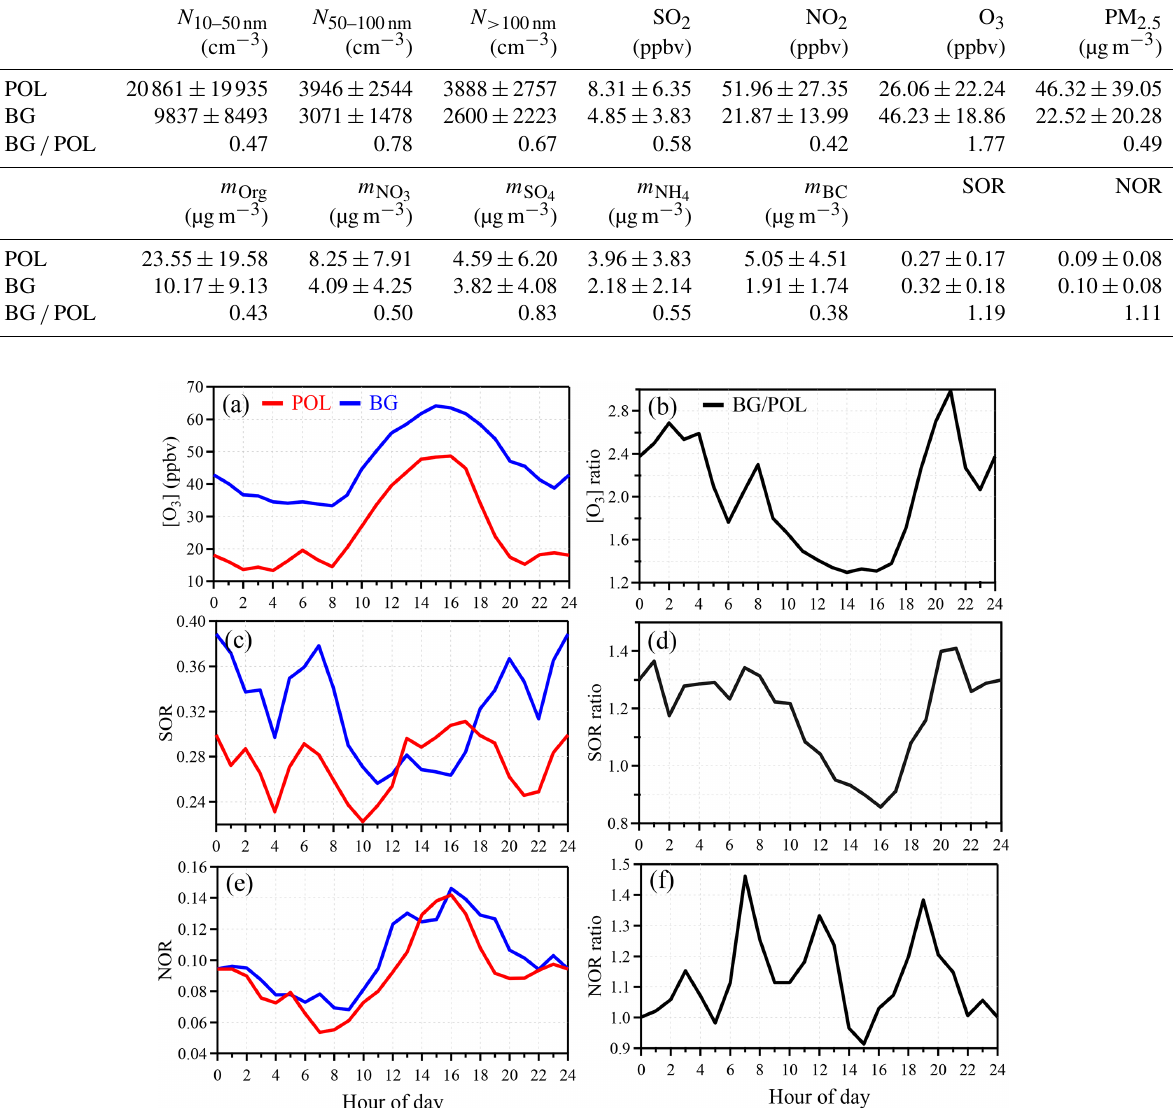
Table 2. Summary of the average aerosol number concentration ( N ) in different size ranges, volume mixing ratios of trace gases, mass concentrations of PM 2 . 5 and different aerosol chemical species, sulfur oxidation ratios (SORs), and nitrogen oxidation ratios (NORs) during the POL and BG periods and their ratios.